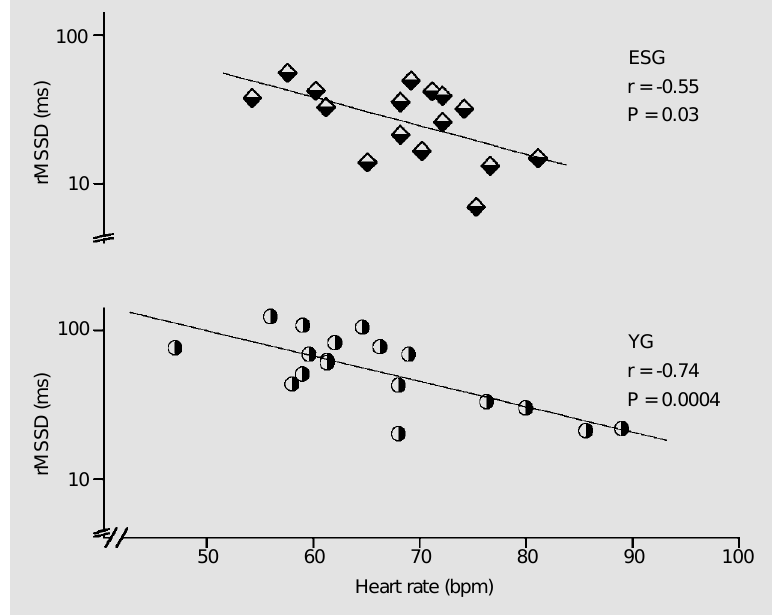
1.Figure 1 - Fitted regression line of natural log transformation of rMSSD (in ms) as a function of resting heart rate (bpm) for ESG (N = 16) and YG (N = 18). For abbreviations, see legend to Table